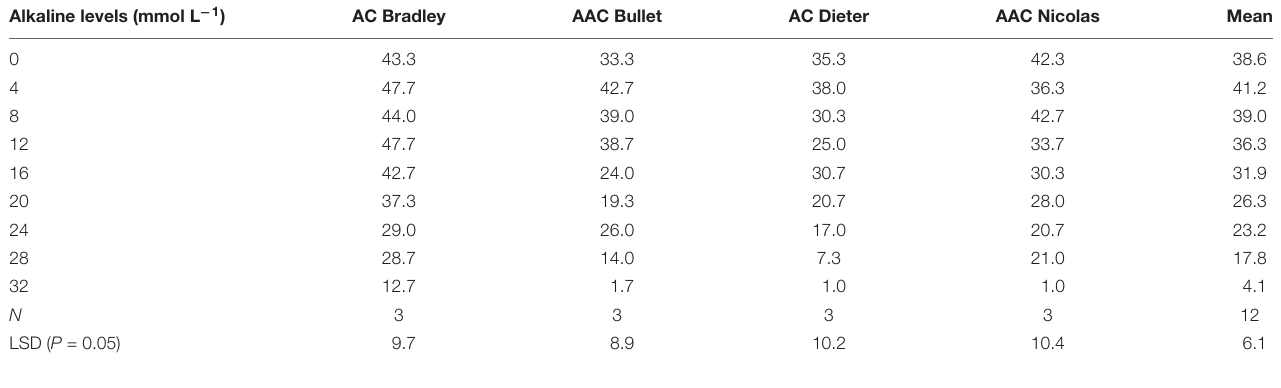
TABLE 3 | Number of germinated seeds (out of 50) for four oat genotypes under different concentrations of alkali. Alkaline levels (mmol L − 1 ) AC